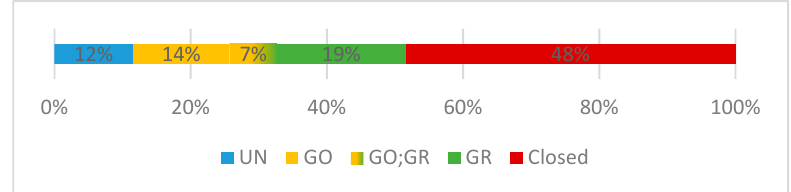
Figure 6. Open availability by 1findr for articles published between 2011 and 2016.